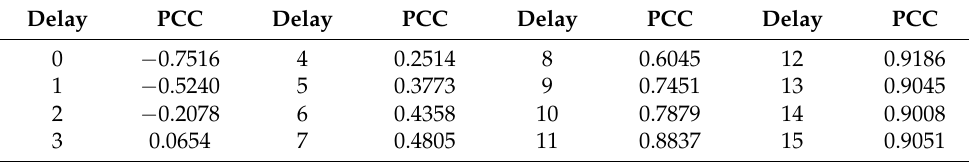
Table 2. Pearson correlation coefficient for Lombardy.